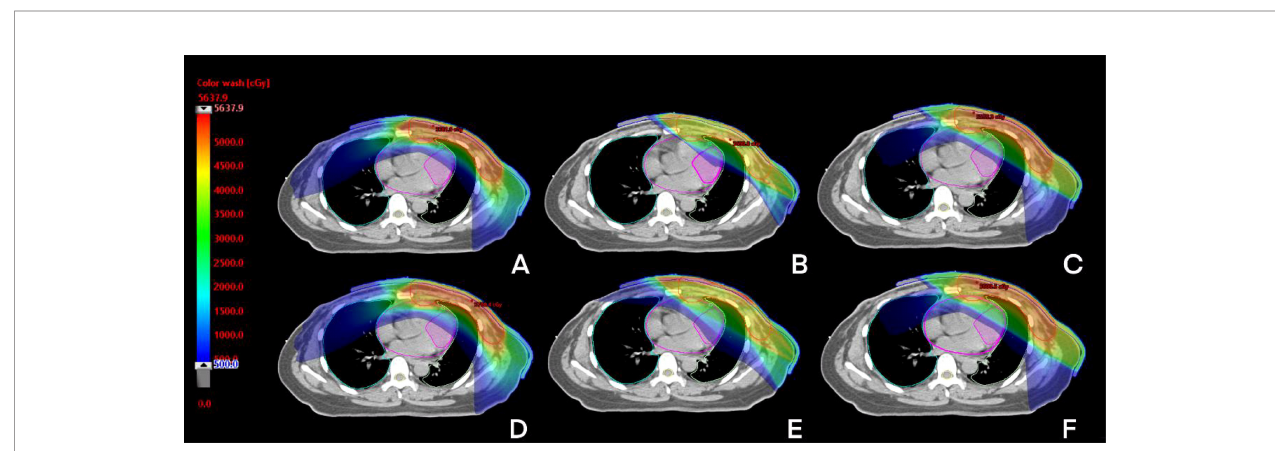
FIGURE 4 | The dose distribution of three techniques before and after setup error re-calculation. A, B, C before setup error [T-VMAT (A) , IMRT (B) , H-VMAT (C) ], (D – F) after setup error [T-VMAT (D) , IMRT (E) , H-VMAT (F)